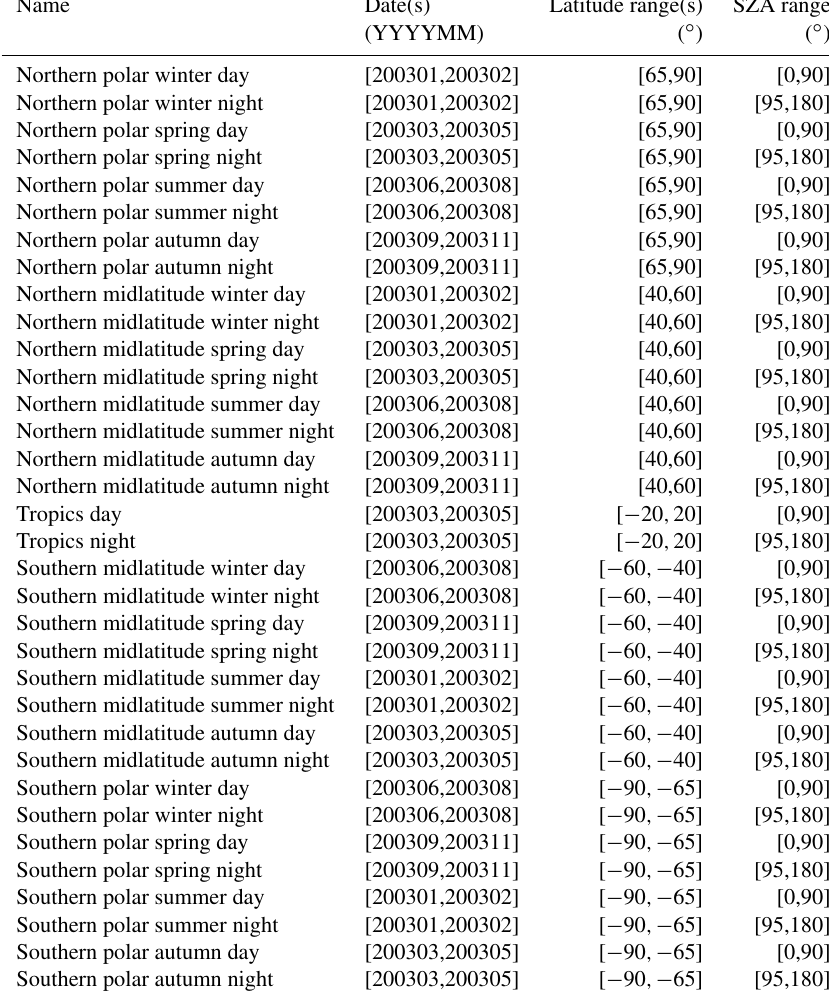
Table A1. Measurements used for error analysis of nominal FR